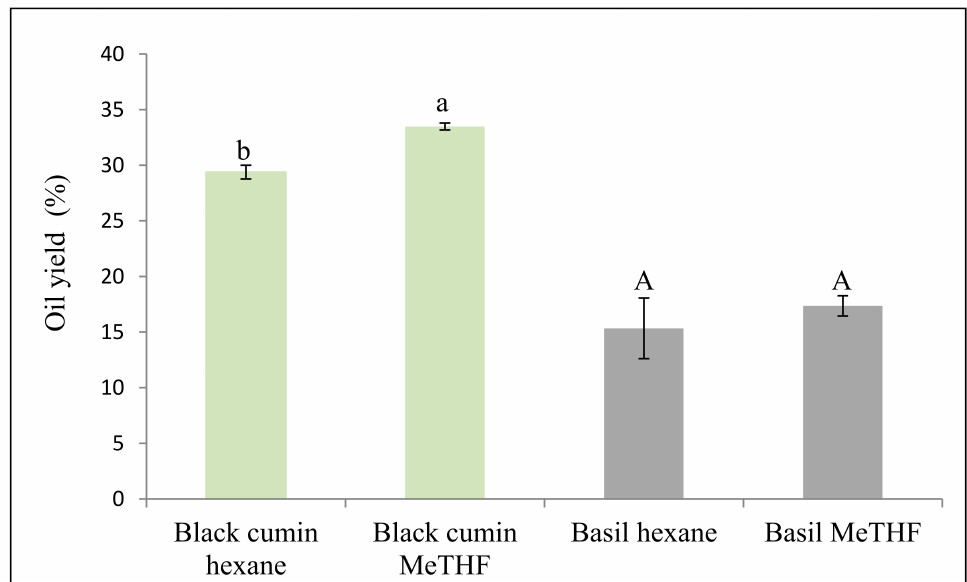
Figure 1. Oil yield of black cumin and basil seeds obtained with conventional and green extractions. Means ± SD, n = 3. The means with small letters (a–b) indicates significant differences ( p < 0.05) between solvents in black cumin and capital letters (A) indicates significant differences ( p < 0.05) between solvents in